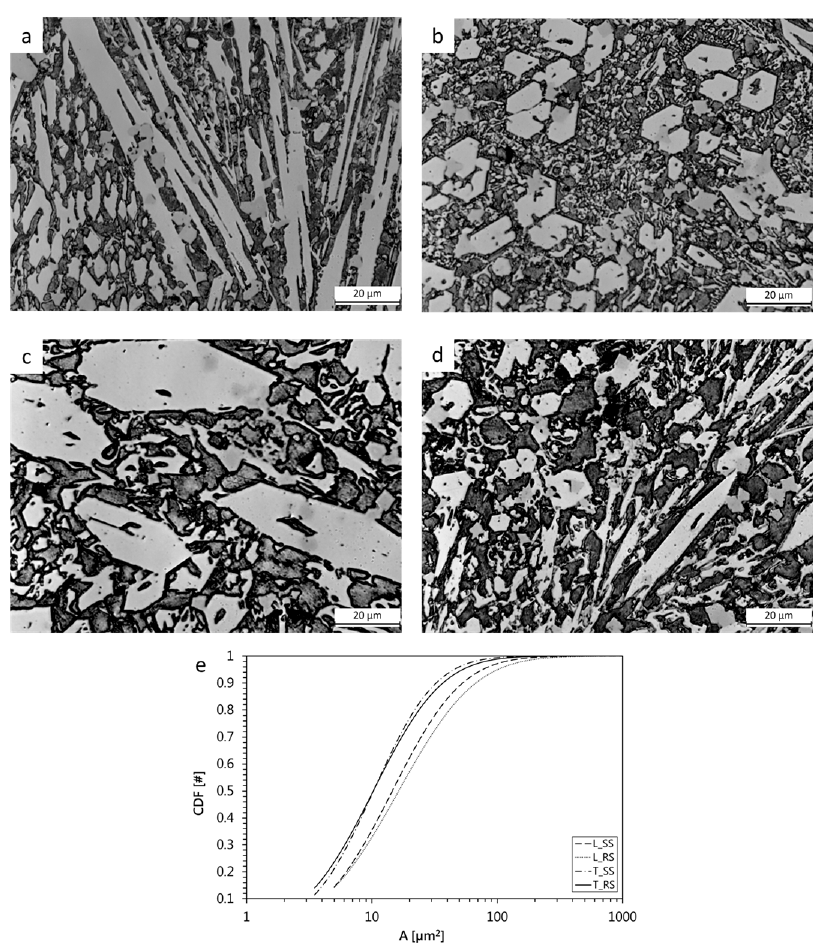
Figure 6. Representative OM micrographs used for the carbide volume fraction (% CVF) evaluation: L-section in the RS ( a ) and SS ( b ); T-section in the resistant side (RS) ( c ) and substrate side (SS) ( d ). ( e ) The cumulative distribution function (CDF) of the carbides’ area A at different locations.